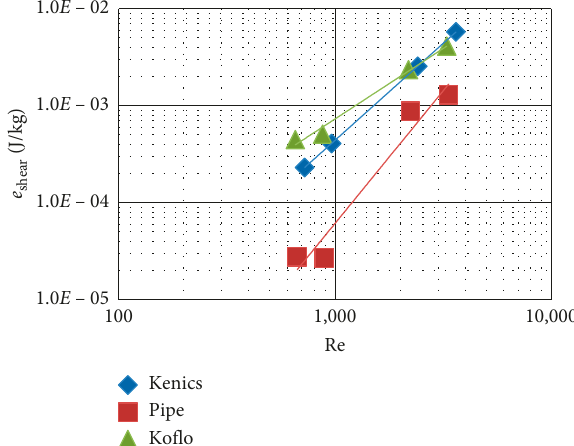
Figure 22: The comparison of the unit shear energy in the tested